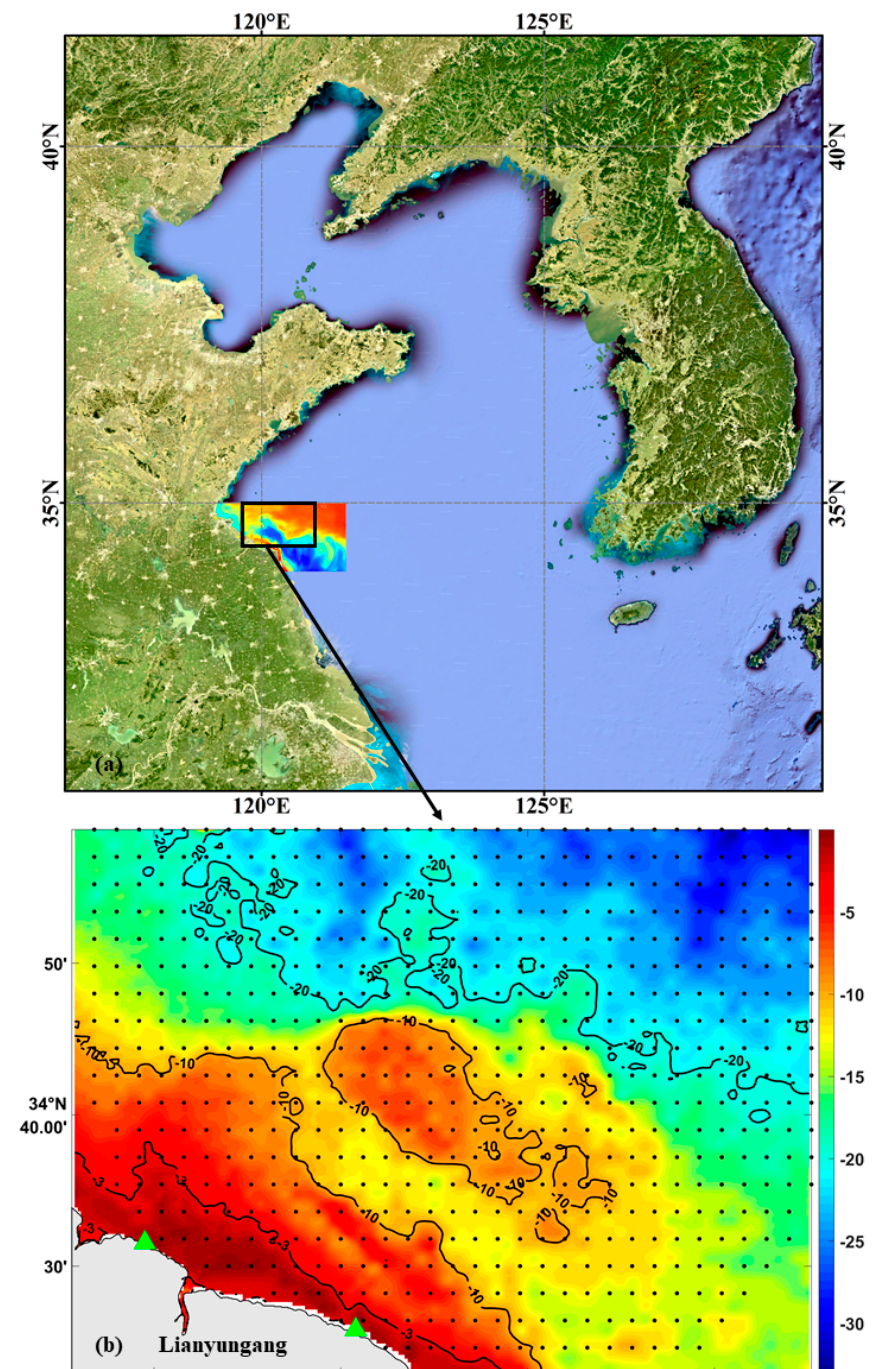
Figure 1. ( a ) The Google satellite image near Lianyungang, China. The region of the color image is the coverage region of Moderate Resolution Imaging Spectroradiometer (MODIS) color patterns. The region of the black solid frame is the coverage region of High-Frequency coastal Radars (HFRs) (90.8 × 66.7 km); ( b ) The bathymetry of the study area (units: m). The background color shows the topography. The black contours are the isobaths, which show the 3, 10, and 20 m bathymetric contours. The black dots are vector points derived from the HFRs. The two green triangles are the locations of the two HFRs. The bathymetry data is from Global Ocean and Land Terrain Models’ (GEBCO’s) gridded bathymetric dataset, which is a global terrain model for ocean and land at 15 arc-second